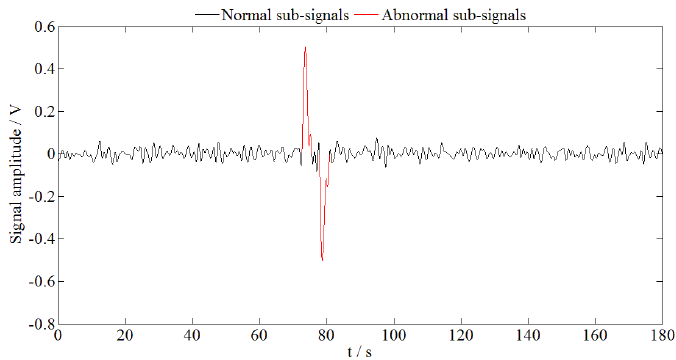
Figure 9. Time domain waveform of abnormal sub-signals isolated from the acoustic